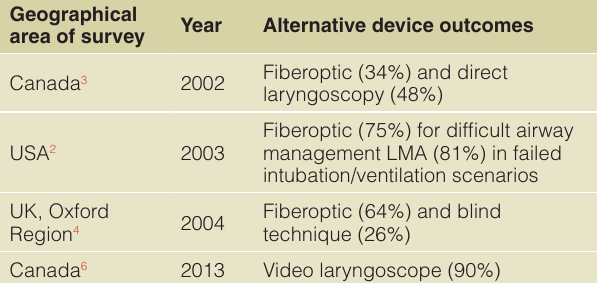
Table 1. Outcomes of surveys completed regarding the preference of alternative airway management devices by geographical area and year completed.